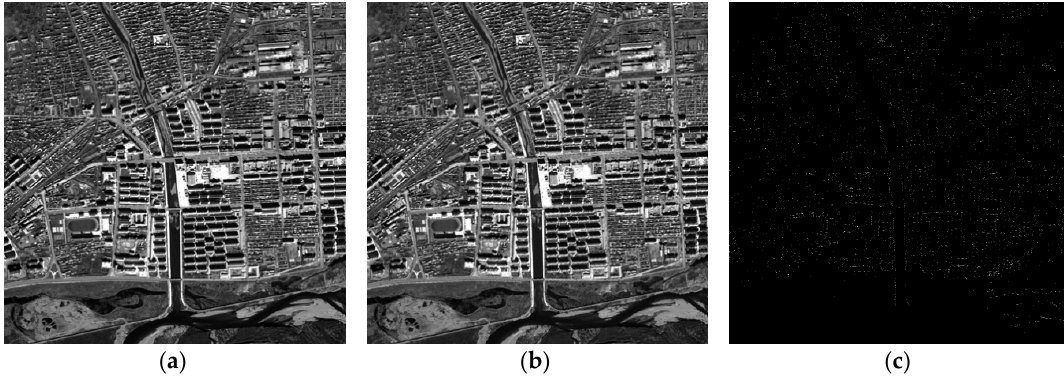
Figure 16. Orthoimages for the second study area: ( a ) by FPGA; and ( b ) by Matlab; and ( c ) the difference of image ( a ) and image ( b ).